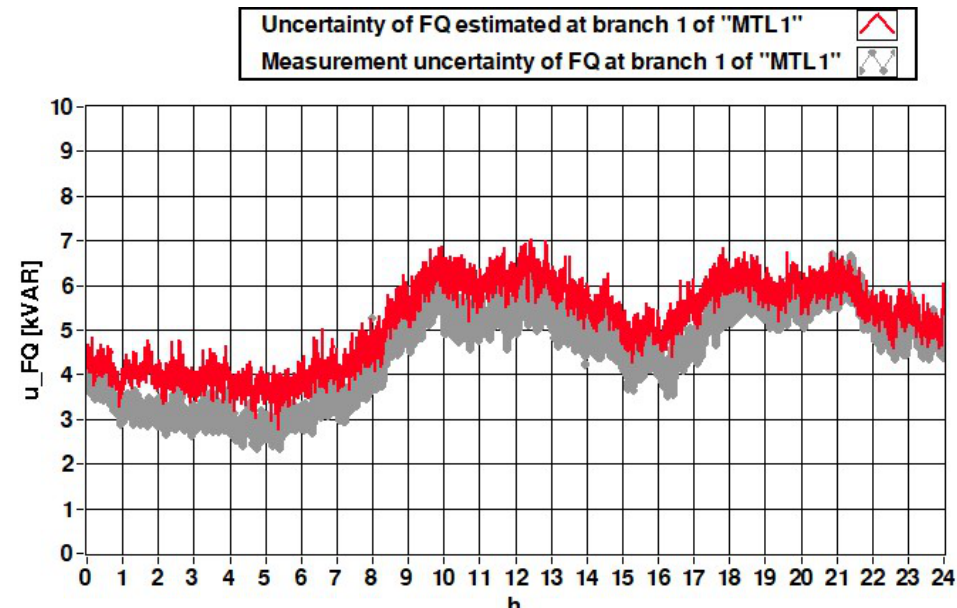
Figure 13. Comparison between the measurement and the calculated uncertainties in the active power flow of branch 1 of the “MTL1” line (31 May 2018).